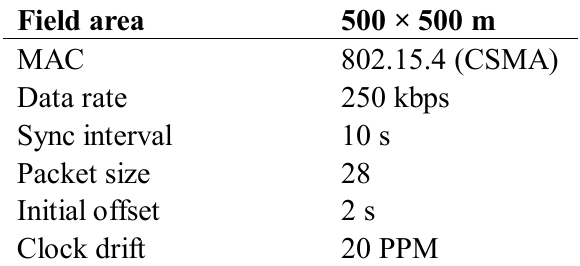
Table 1. Experimental setup for evaluation.